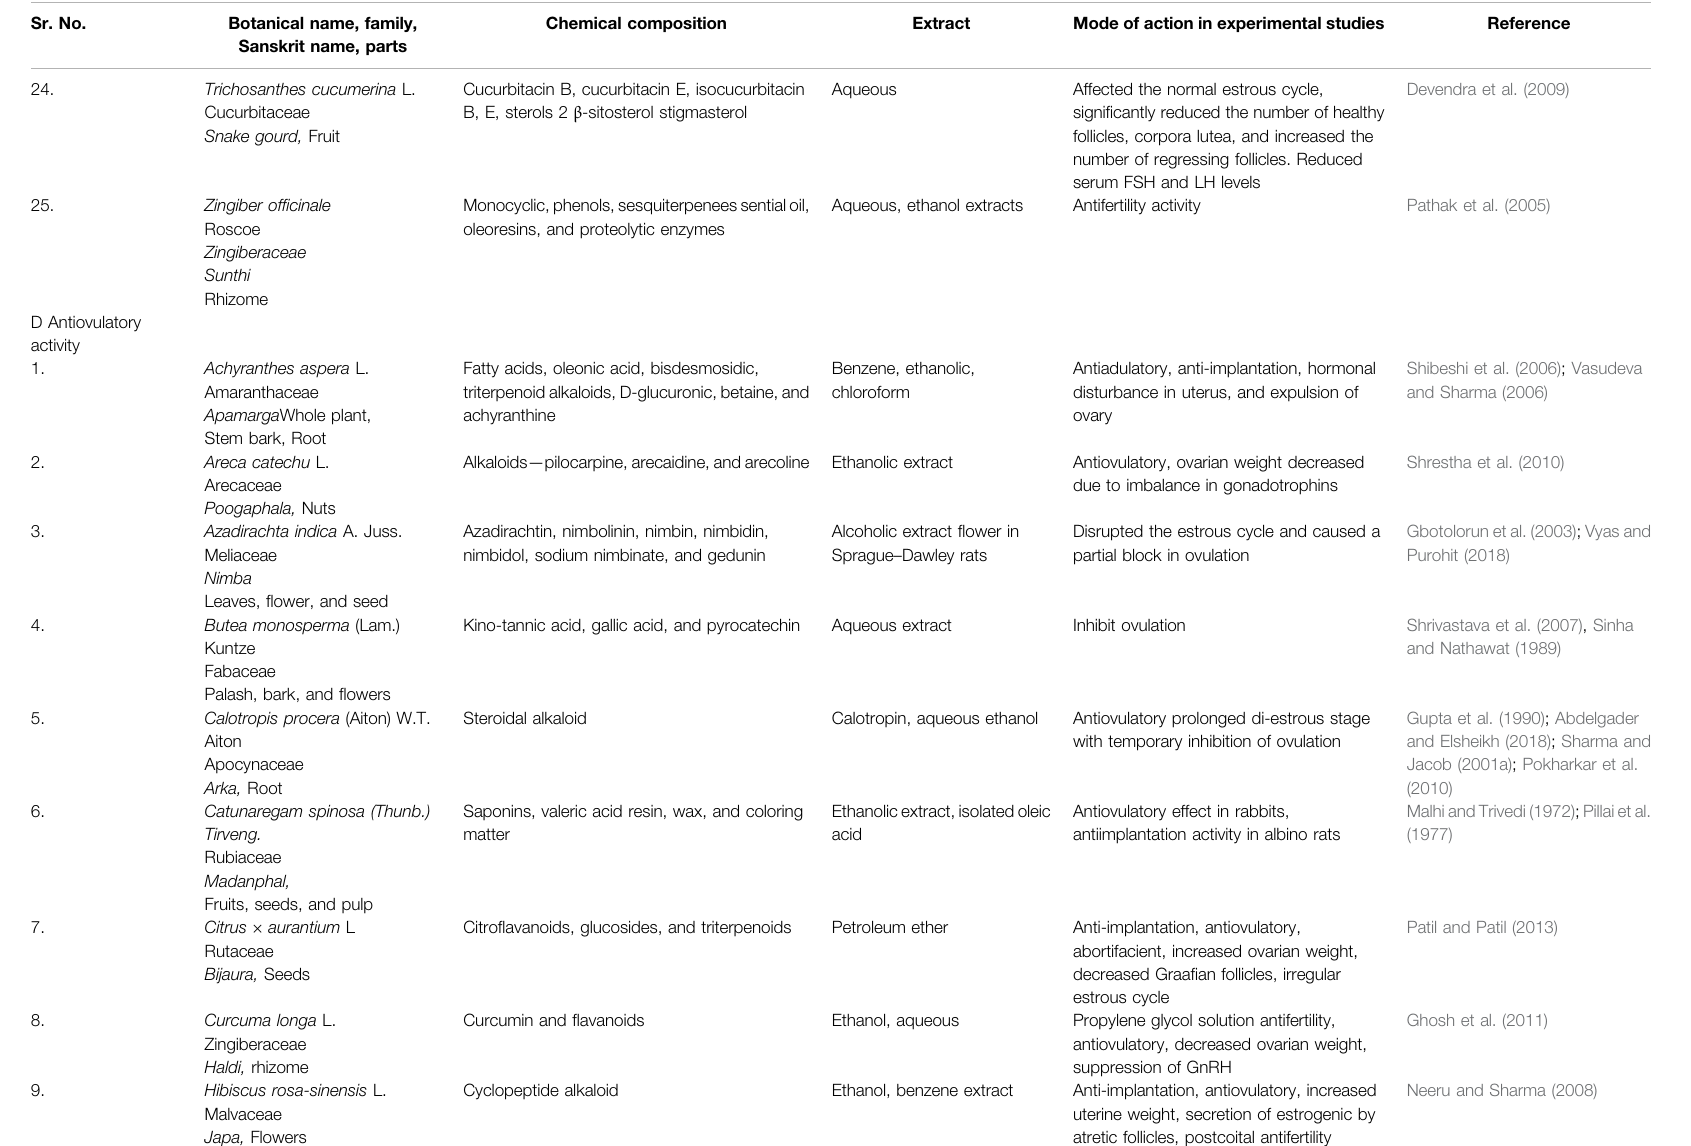
TABLE 2 | ( Continued ) Medicinal plants and their phyotoconstituents validated for various female/male contraceptive activities. Different contraceptive activities studied on medicinal plants could be categorized as follows. Female contraceptive activities: (2A) anti-implantation activity, (2B) aborti fi cation, (2C) antifertility, (2D) antiovulatory, and (2E) antiestrogenic activity. Male contraceptive activities: (2F) antispermatogenic, (2G) spermicidal, and (2H) antiandrogenic